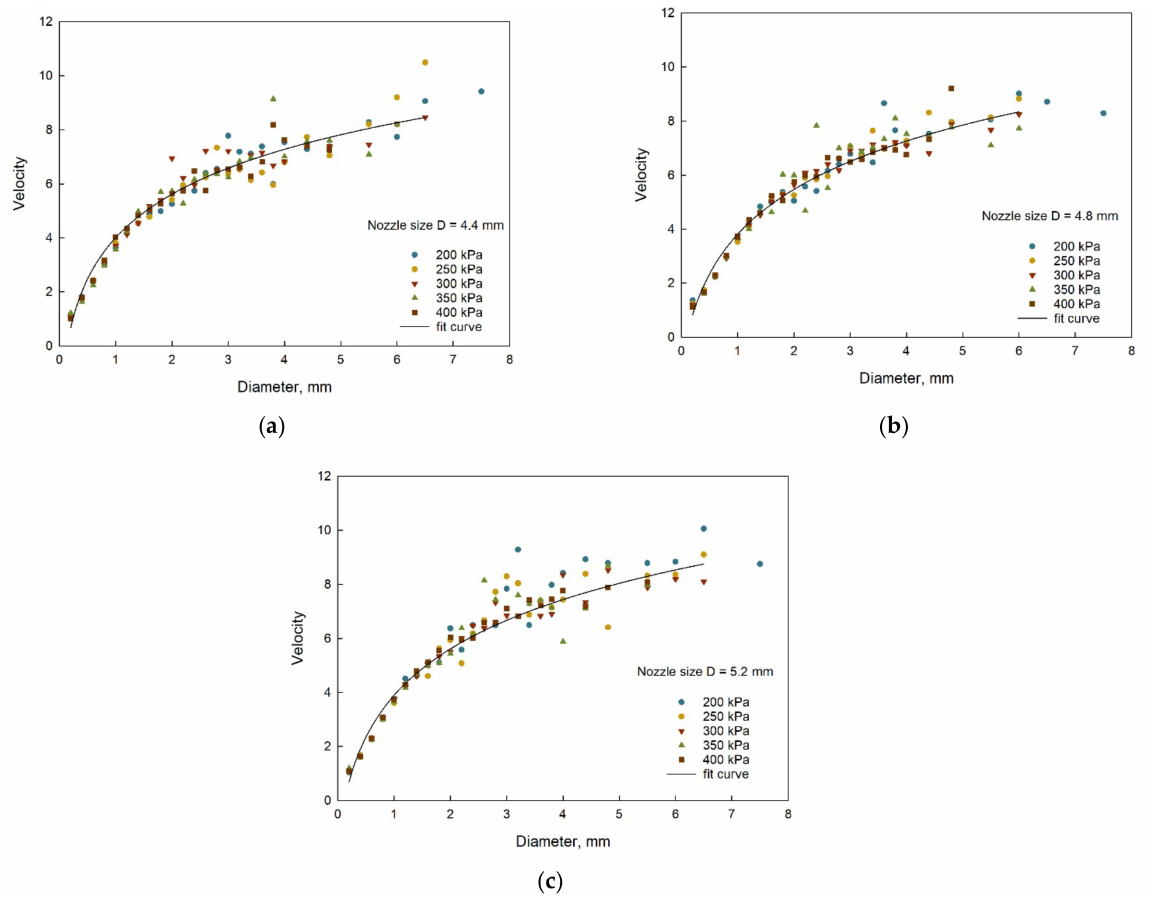
Figure 9. Relationships between droplet mean velocity and droplet diameter with nozzle sizes of